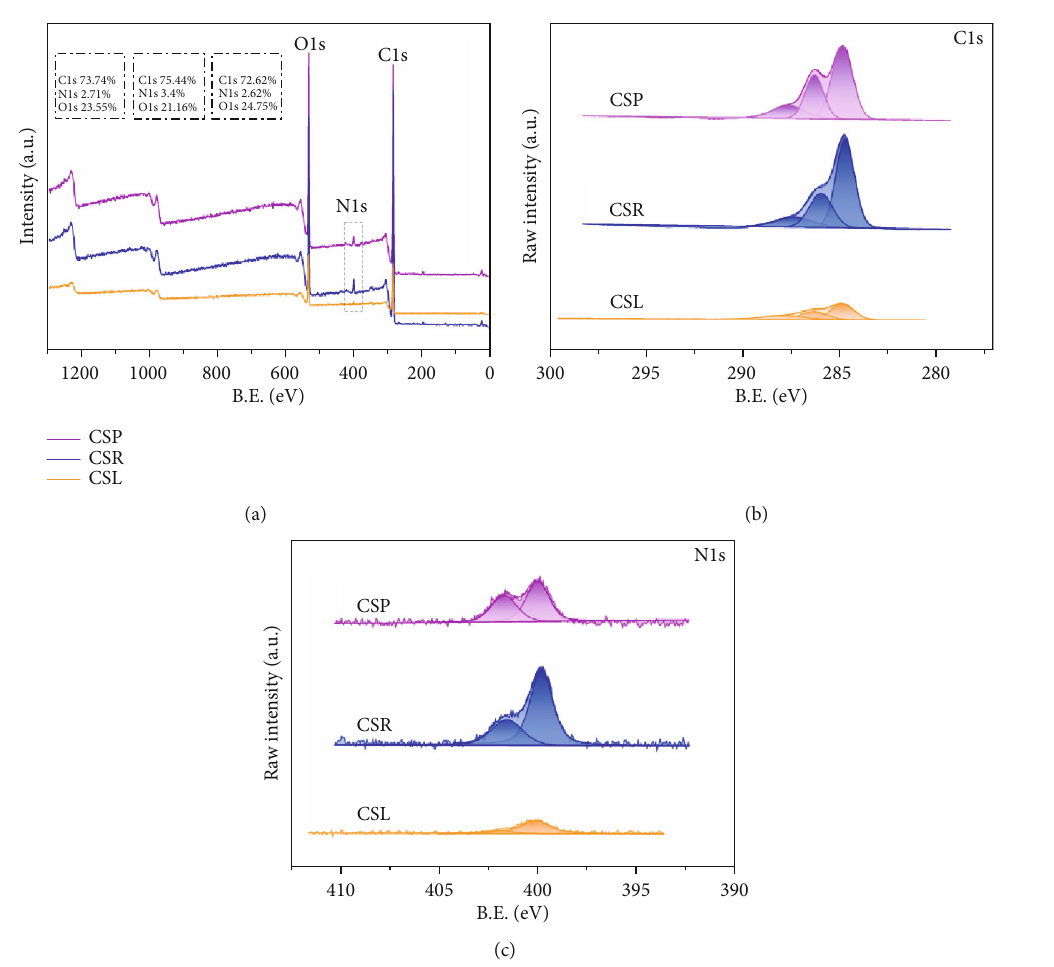
Figure 5: The XPS spectra of three parts of the corn